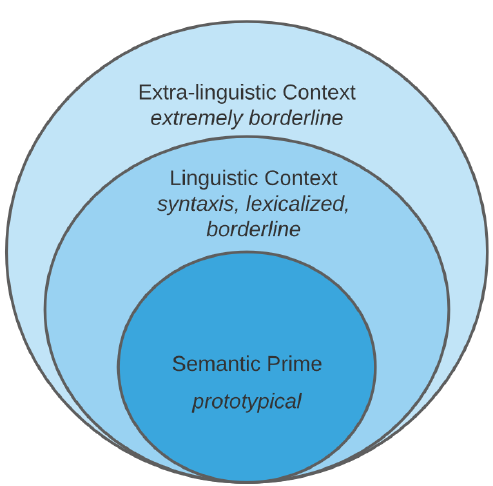
Figure 2. Semantic hierarchy of evaluative